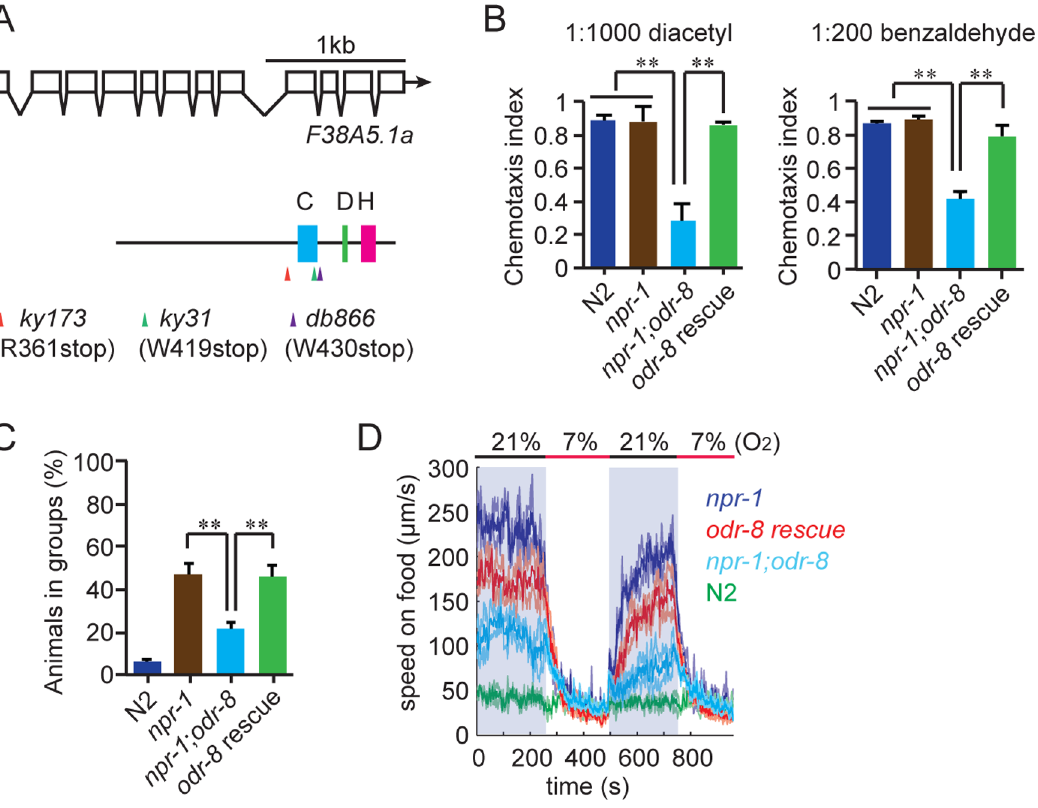
Figure 1. odr-8 mutants are defective in Ufm1 specific protease 2. (A) The UfSP2 gene corresponds to ORF F38A5.1. Shown are the exon/ intron structure of the gene and the location of the Cysteine (blue), Histidine (green) and Aspartate (pink) boxes containing catalytic residues in the papain fold. The location of stop codons associated with the db866 , ky173 and ky31 mutations is also indicated. (B–D). A transgene carrying F38A5.1a genomic fragment rescues odr-8 defects in olfaction (B), aggregation (C), and responses to changes in O 2 (D). **, p , 0.01 compared to non-transgenic controls (ANOVA, Bonferroni’s multiple comparisons test).